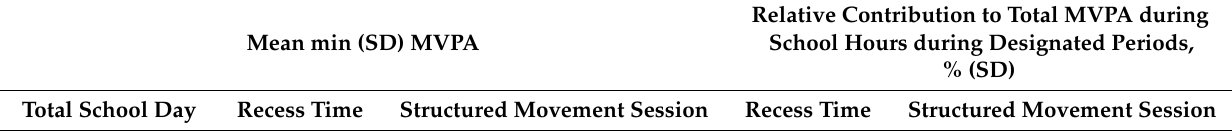
Table 3. MVPA during total school day, recess time, and structured movement sessions, and relative contribution of the MVPA carried out during these designated time periods to total MVPA during school hours, by gender.